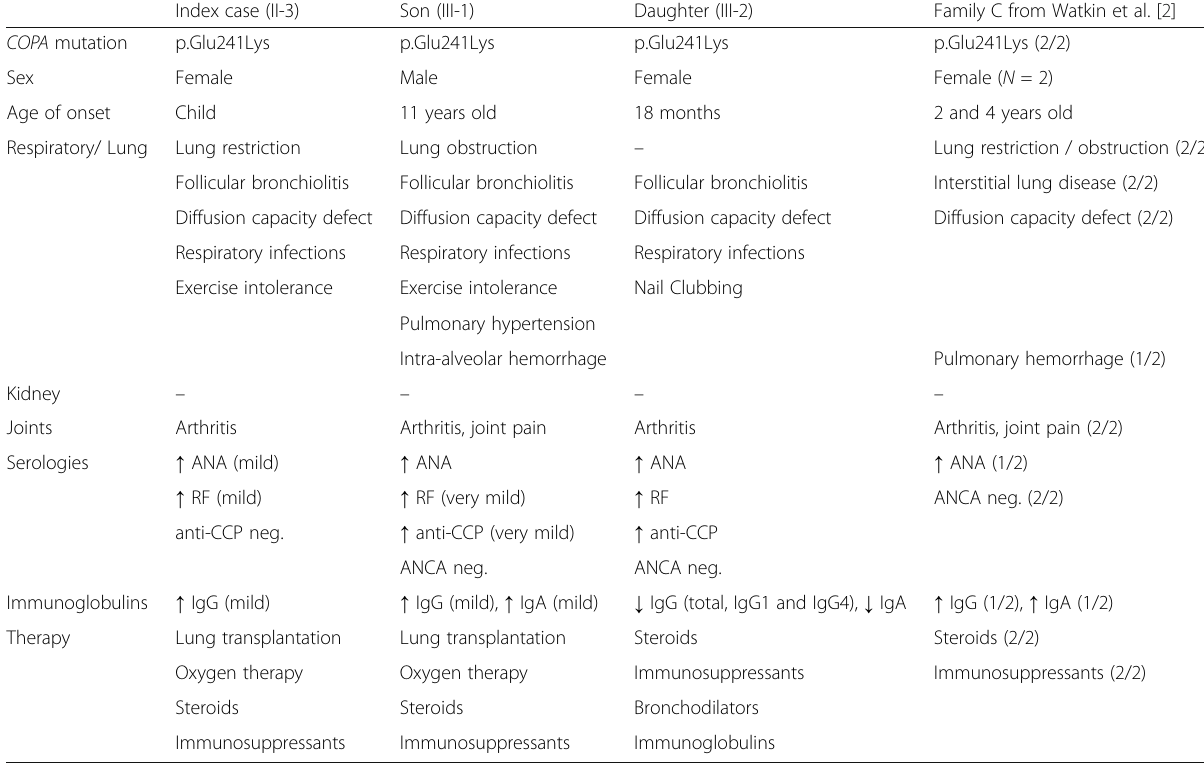
Table 1 The reported phenotypes for two affected family members of Family C in Watkin et al. compared to the phenotypes seen in the affected